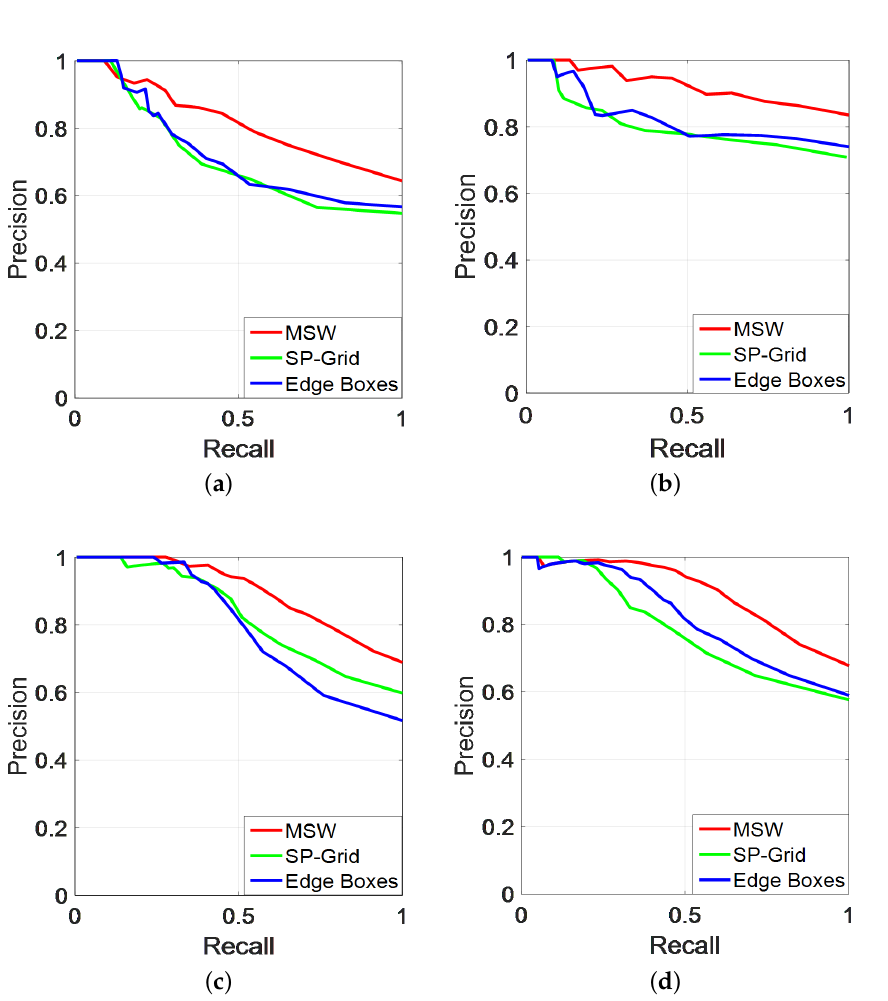
Figure 4. Performance of MSW, SP-Grid and Edge Boxes on: ( a ) Mapillary Berlin; ( b ) Gardens Point Campus; ( c ) Freiburg Across Seasons; and ( d ) Oxford RobotCar dataset.